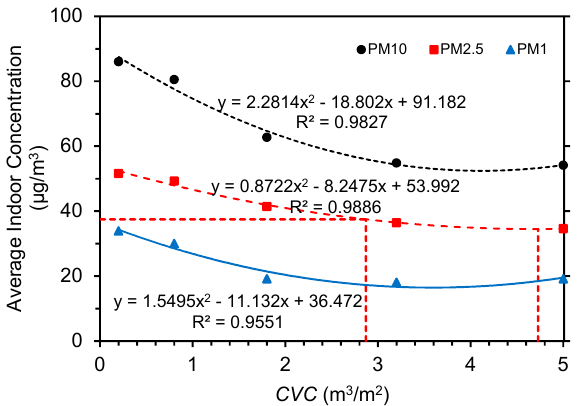
Figure 14. Relationships between CVC and average indoor particle concentrations (oncoming wind speed = 4.0 m/s, and wall porosity = 3.5%).